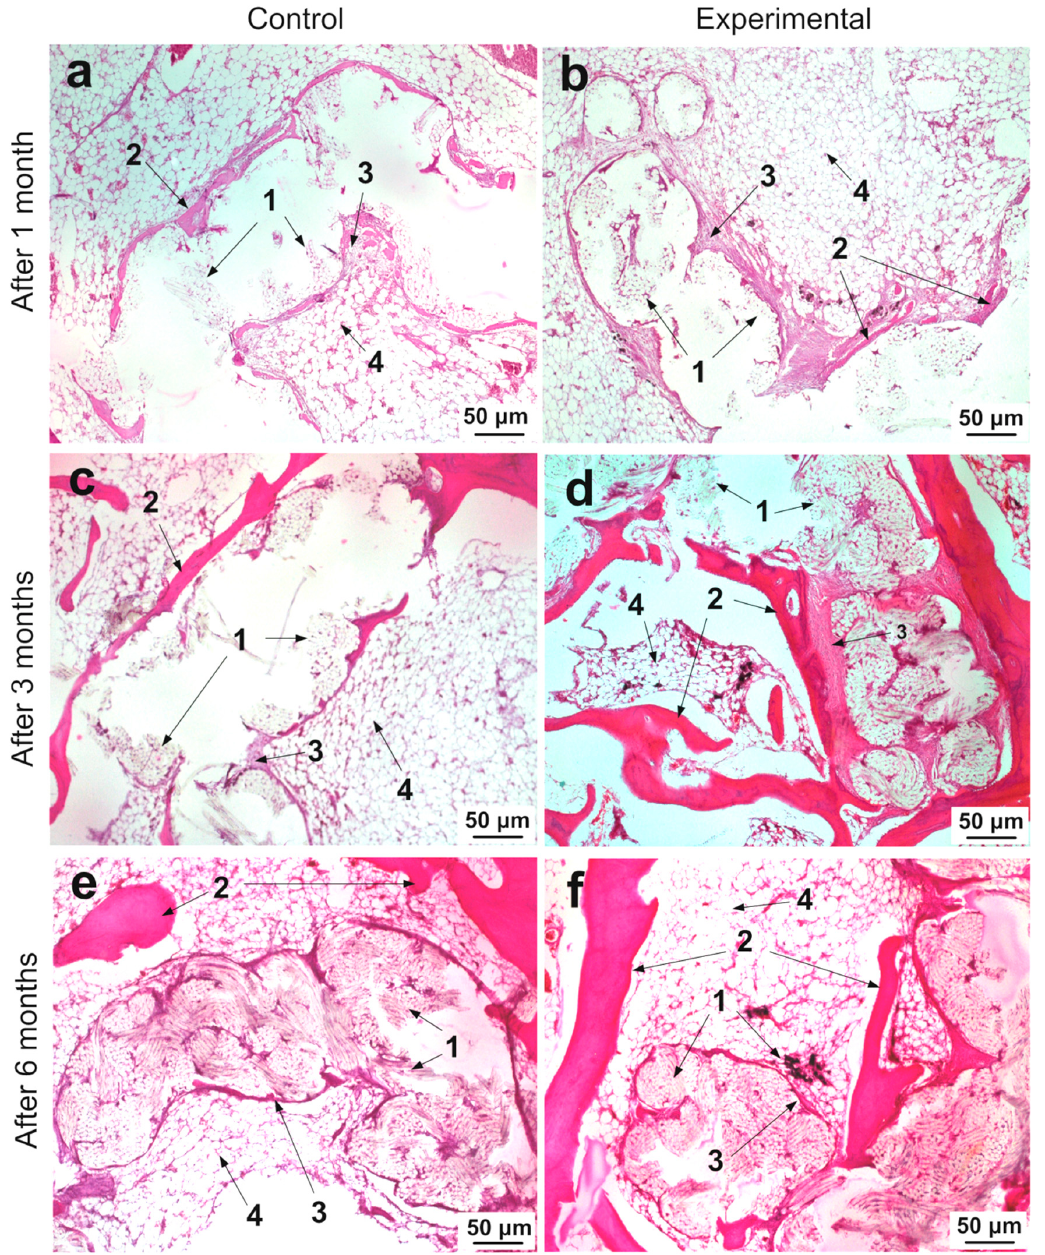
Figure 8. Images of histological sections in the implantation area after 1 ( a , b ), 3 ( c , d ), and 6 ( e , f ) months of the control ( a , c , e ) and a PET tape coated with SWCNT/collagen ( b , d , f ), where 1 —a PET tape fiber; 2 —bone trabeculae; 3 —connective tissue; 4 —reticular tissue.